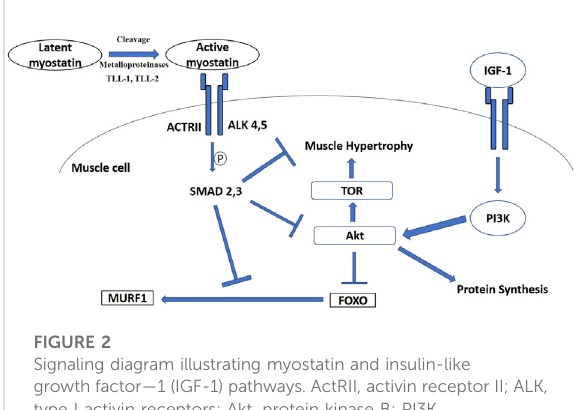
FIGURE 2 Signaling diagram illustrating myostatin and insulin-like growth factor — 1 (IGF-1) pathways. ActRII, activin receptor II; ALK, type I activin receptors; Akt, protein kinase B; PI3K, phosphatidylinositol 3-kinase; TOR, target of rapamycin; TLL, Tolloid-like protein; FOXO, Forkhead Box-O; MURF1, muscle- speci fi c E3 ubiquitin ligase muscle RING- fi nger